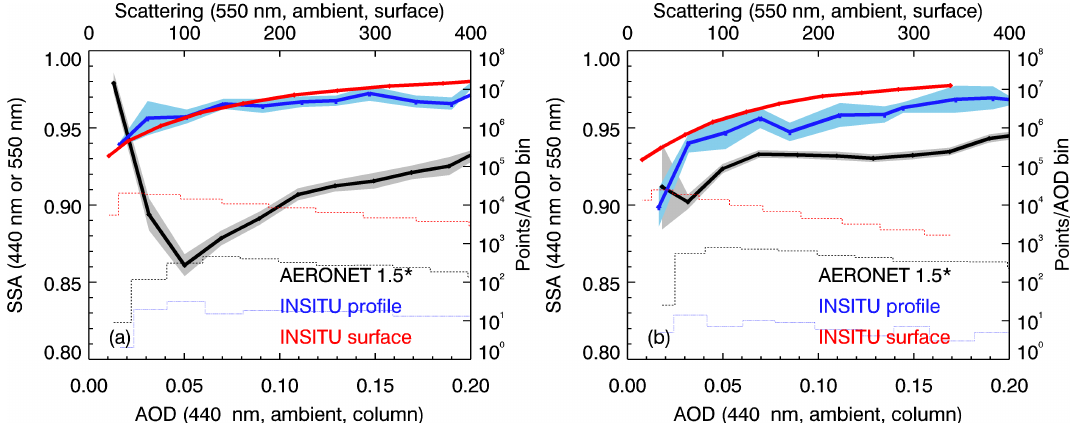
Figure 9. Systematic variability of SSA as a function of loading for (a) BND and (b) SGP for AERONET 1.5 ∗ AOD and SSA (black lines), AOD and SSA from in situ profiles (blue lines) and in situ scattering and SSA from surface measurements (red lines). Solid lines indicate mean values of SSA and AOD for each 0.05 AOD bin (10Mm − 1 scattering bin). Shaded areas represent mean standard error (mean standard error for surface data is within thickness of red line). Histograms indicate the number of points in each AOD (or scattering) bin. Plot based on BND and SGP AERONET data (date range: 1996–2012), BND INSITU profile data (date range: 2006–2012) and SGP INSITU profile data (date range: 2006–2007). Surface data (orange lines) are for 550nm, low-RH, hourly in situ data from the surface sites at BND (date range: 1997–2013) and SGP (date range: 1998–2013). AERONET 1.5 ∗ is from Level 1.5 retrievals with a corresponding Level 2 almucantar